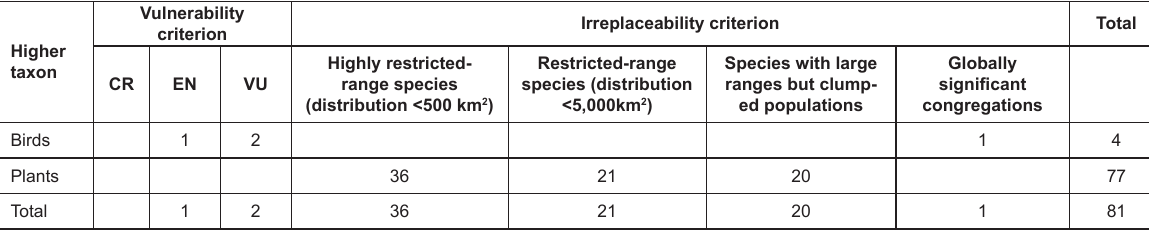
Table 1. Summary of the numbers of species of birds and plants triggering each of the KBA criteria and subcriteria